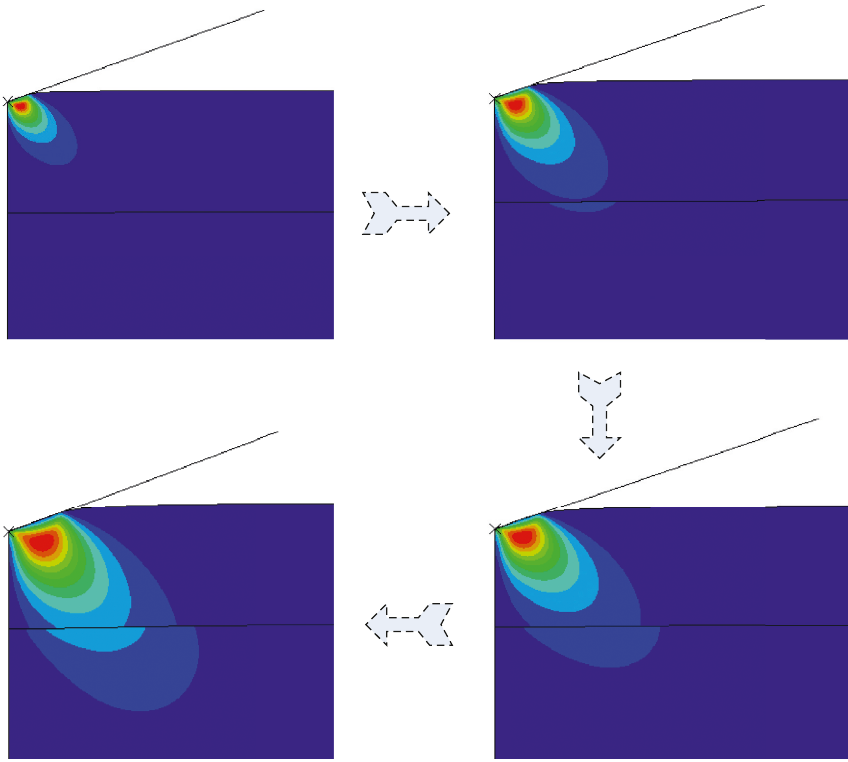
Figure 2: The stress distribution at different indentation